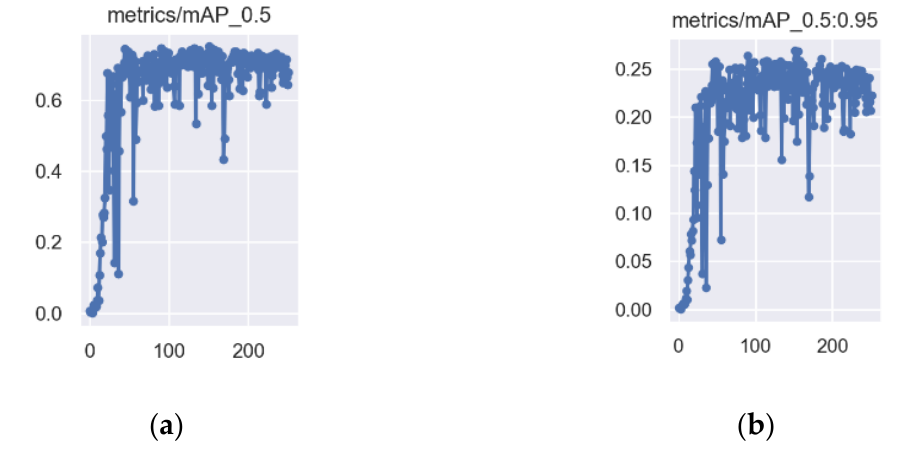
Figure A2. The precision/recall curve and F 1 Score /confidence curve of YOLOV5n: ( a ) PR_curve; ( b ) F1_curve.